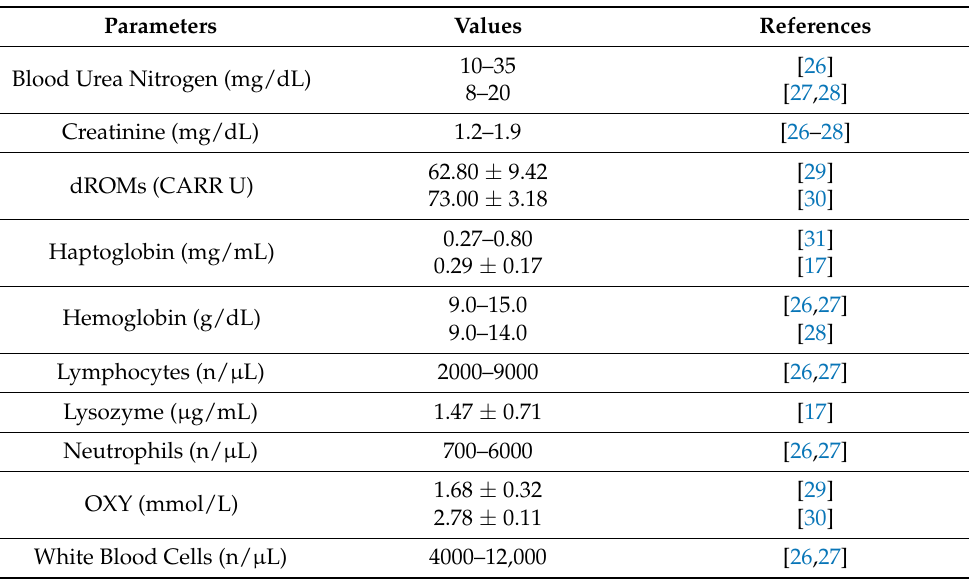
Table 4. Reference values of analyzed clinical parameters for sheep.